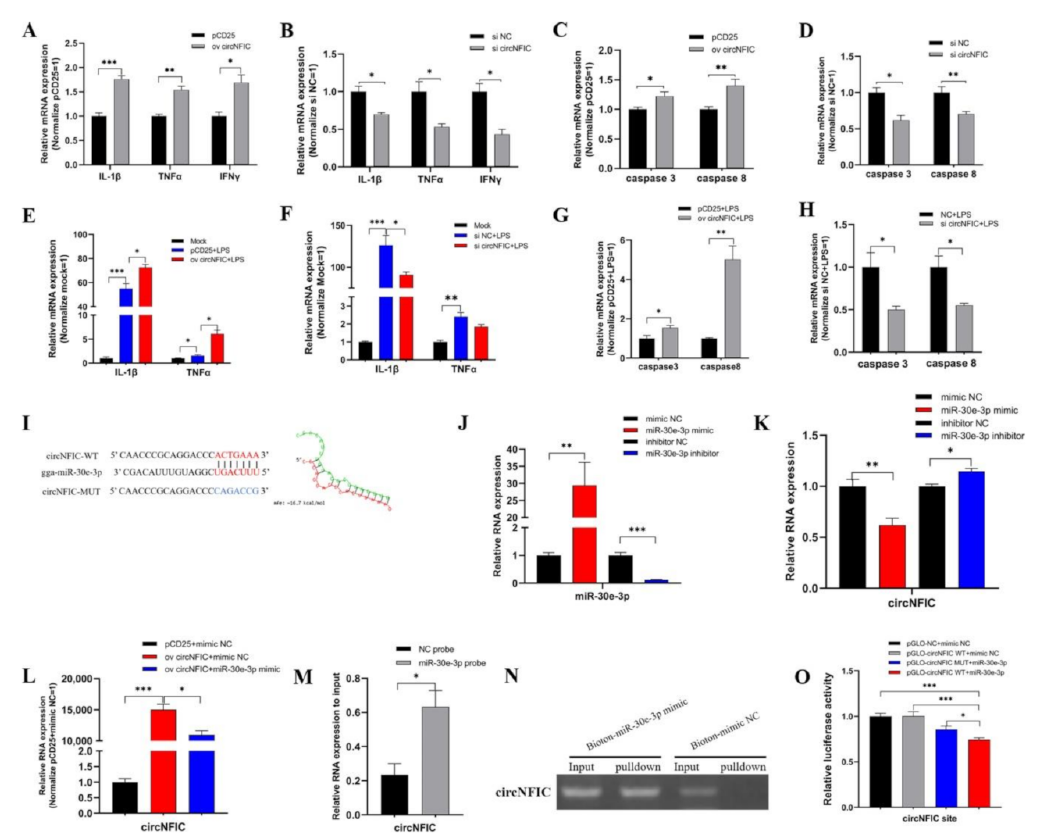
Figure 2. CircNFIC aggravates inflammation and apoptosis, and directly targets miR-30e-3p. ( A , B ) The qRT-PCR assays showed that the mRNA expression levels of IL-1 β , TNF α , and IFN γ after transfecting overexpression vector and siRNA of circNFIC in HD11. ( C , D ) The expression levels of caspase 3 and caspase 8 with overexpression and knockdown of circNFIC in HD11. ( E , F ) The levels of IL-1 β , TNF α , and IFN γ with overexpression and knockdown of circNFIC in HD11 with LPS stimulation. ( G , H ) After overexpression and knockdown of circNFIC, the levels of caspase 3 and caspase 8 in HD11 with LPS stimulation. ( I ) The potential binding site sequence (were highlighted in red) of miR-30e-3p on circNFIC, and the interaction model between miR-30e-3p and circNFIC, by RNAhybrid software. ( J ) The efficiency of overexpression and knockdown of miR-30e-3p was detected by qRT-PCR. ( K , L ) The expression of circNFIC was suppressed by miR-30e-3p. ( M ) The enrichment of circNFIC in the biotinylated miR-30e-3p mimics pull-down RNA. ( N ) The qRT-PCR products of circNFIC in RNA pull-down. ( O ) Dual-luciferase assay verified the binding relationship between circNFIC and miR-30e-3p. Data are presented as mean ± SEM ( n ≥ 3 biologically independent samples). * p < 0.05; ** p < 0.01; *** p < 0.001 (Student’s t